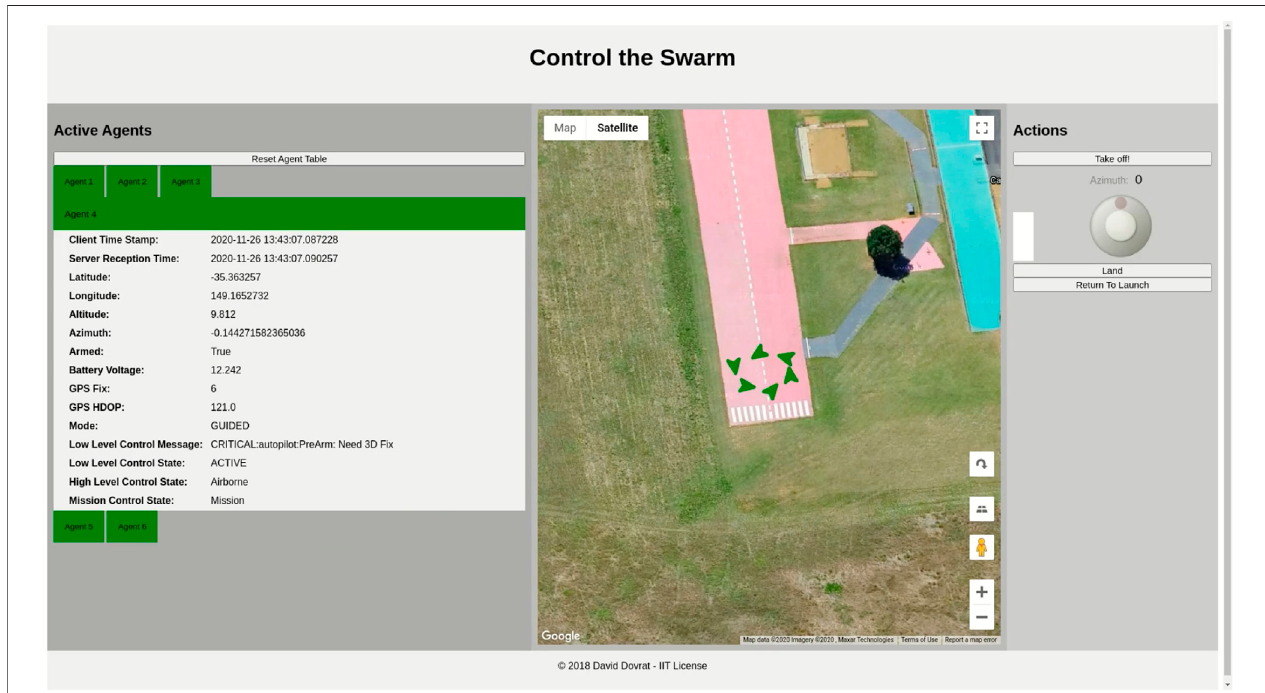
FIGURE 11 | AntAlate template application demonstrated using ArduCopter ’ s Software in The Loop (SITL) simulator. Screen capture from the AntAlate Server Graphical User Interface (GUI).